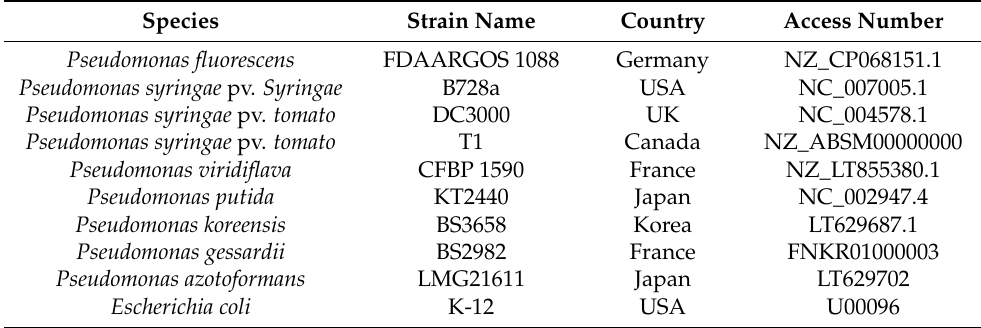
Table 3. Information details of strains used as reference for both 16SrRNA and MLSA analysis (complete